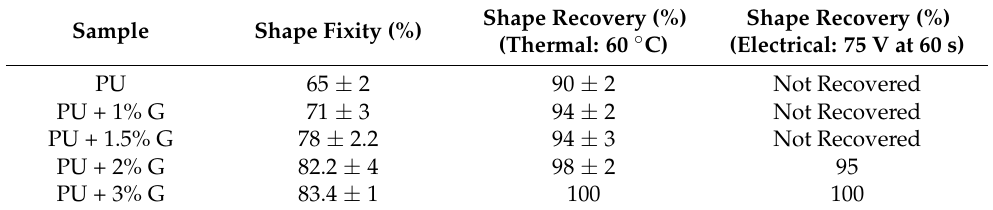
Figure 7. Variation in flowing electrical current vs. applied voltage for PU and PU/graphene nanocomposites [115]. PU = polyurethane; G = graphene. Reproduced with permission from Elsevier. Table 1. Shape memory properties of PU and PU/graphene nanocomposites [115]. PU = polyurethane; G = graphene. Reproduced with permission from Elsevier.